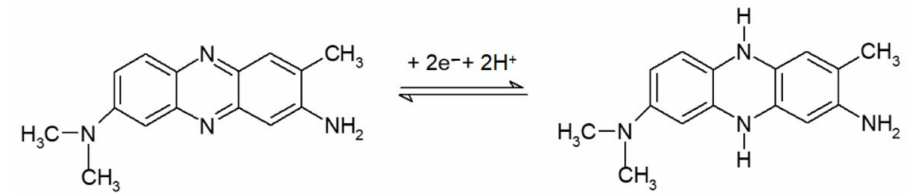
Figure 5. Reaction scheme of NR protonation in the acidic medium